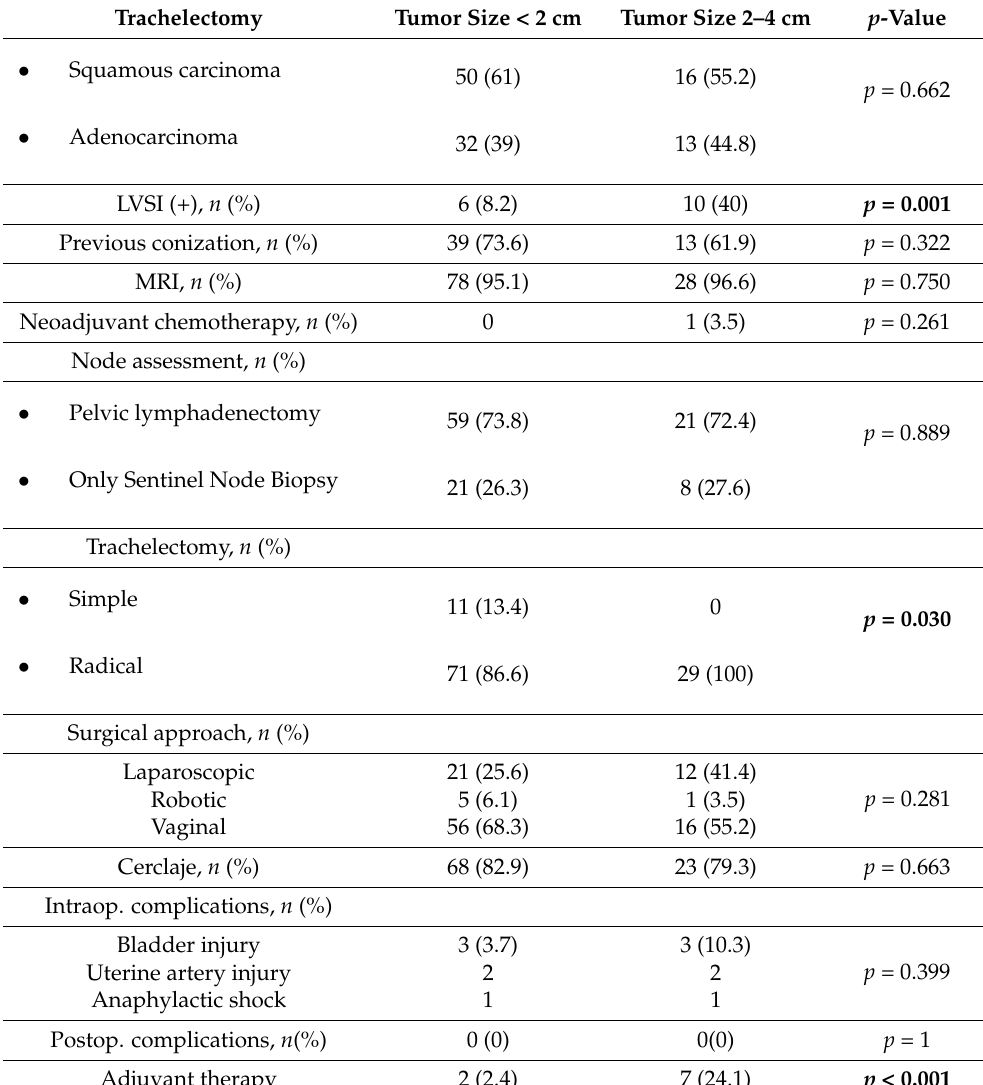
Table 1. Cont. Trachelectomy Tumor Size < 2 cm Tumor Size 2–4 cm p